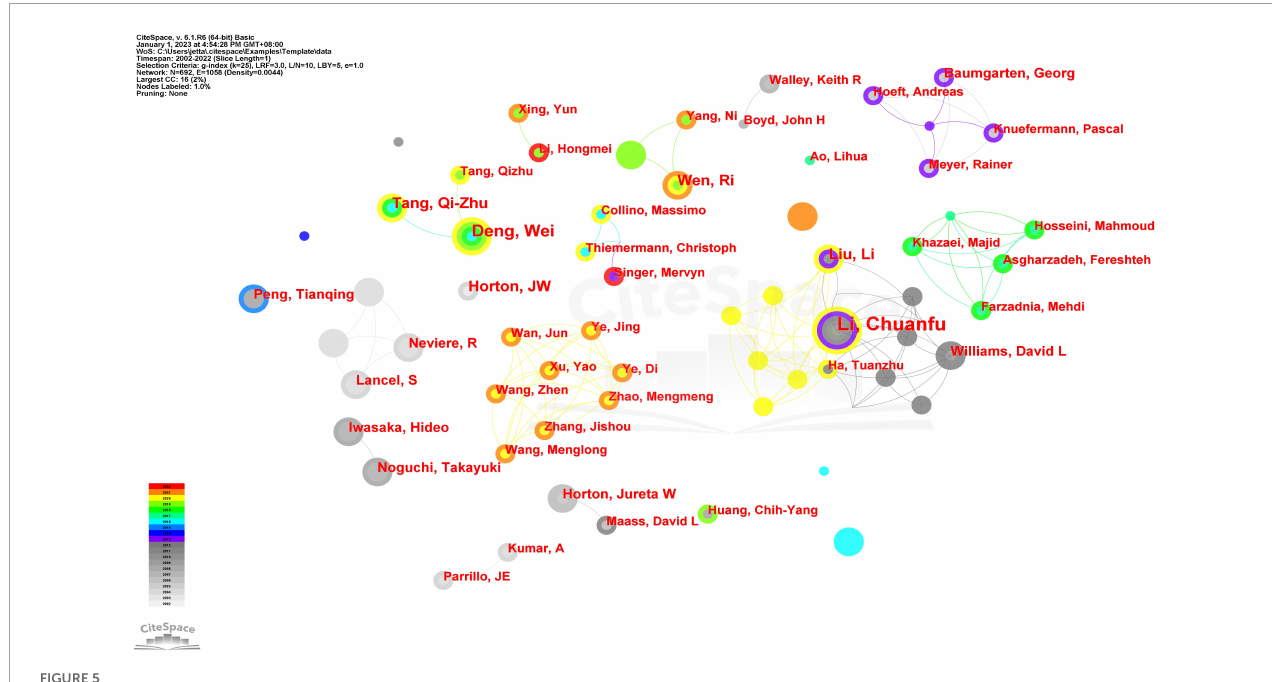
FIGURE5 CiteSpace visualization map of authors related to